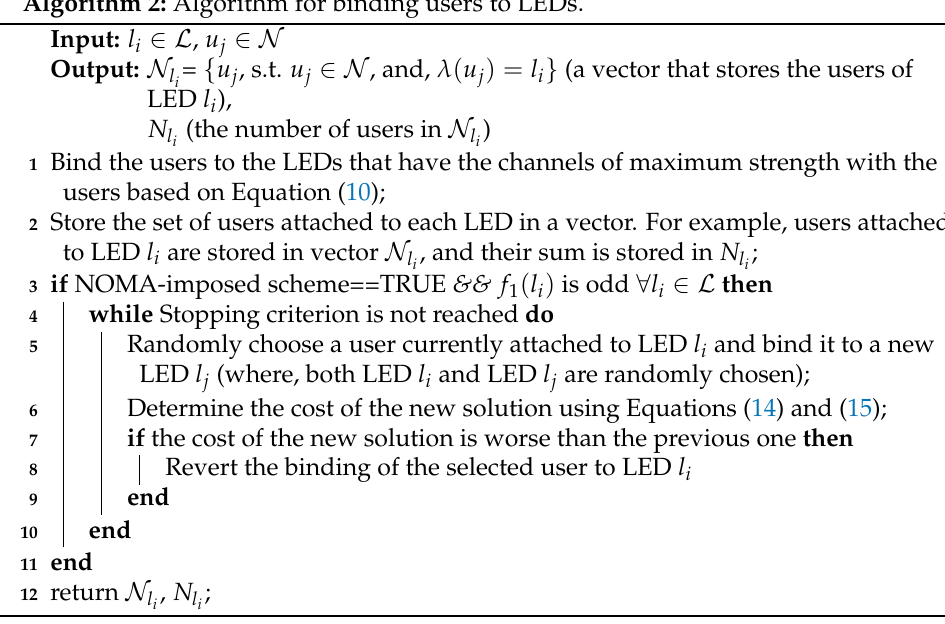
Algorithm 2: Algorithm for binding users to